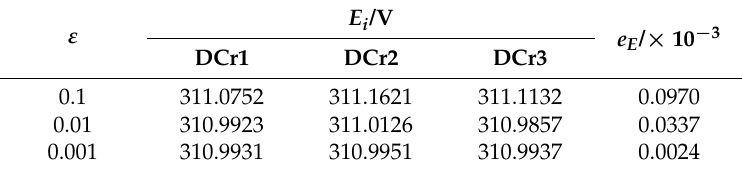
Table 4. Convergence results and deviations under different convergence